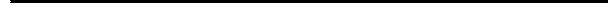
Fig. 2 Normal DSB formation but altered numbers of recombination markers in Atr S/S cells. a – c Left panels, quanti fi cation of total foci per spermatocyte for RAD51 ( a ), DMC1 ( b ), or RPA ( c ) at the indicated stages. Each point is the focus count for a single cell. Horizontal lines denote the mean. Right panels, representative images of spermatocytes stained for the indicated proteins. Scale bar = 10 μ m. All p values are from t test pairwise comparisons; no p value is stated if the comparison was not statistically signi fi cant ( p > 0.05). d Quanti fi cation of SPO11-oligonucleotide complexes. A representative experiment is shown. Anti-SPO11 immunoprecipitates from two testes of each genotype were labeled with terminal transferase and [ α - 32 P]-dCTP, resolved by SDS-PAGE, and detected by autoradiography (top) and western blotting analysis (bottom). Vertical line indicates the signal from SPO11-oligonucleotide complexes; asterisk indicates non-speci fi c signal from the labeling reaction; positions of the two major SPO11 splicing isoforms, α and β are shown; and arrowheads denote the migration position of immunoglobulin heavy chain. SPO11- oligonucleotide signal and testis weights are indicated (mean ± SD, N =